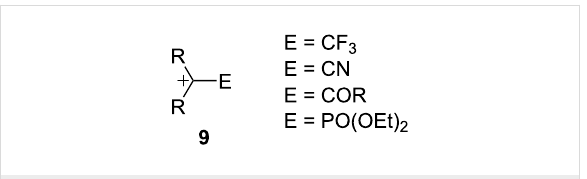
Figure 1: Electron-deficient